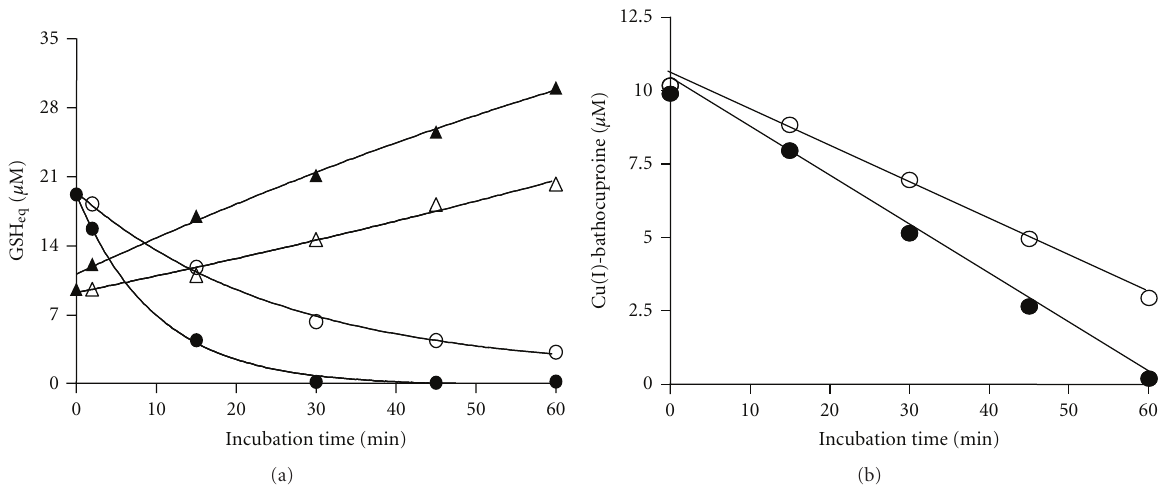
Figure 6: (a) Changes in the thiol-titratable groups and EDTA-releasable GSSG during the exposure of a Cu(I)-[GSH] 2 complex to Tempol. For the determination of TTG (circles), a mixture of DTNB (24 μ M) plus EDTA (2mM), and for that of GSSG (triangles), a mixture of NADPH (0.2mM) plus glutathione reductase (2U/mL) and EDTA (2mM) were added to samples obtained from the incubation (0–60 min at 30 ◦ C) of the Cu(I)-[GSH] 2 complex (10 μ M) both in the presence (closed symbols) or in the absence (open symbols) of Tempol (8 μ M). Results are expressed as GSH equivalents ( μ M). (b) Changes in copper (I) during the exposure of a Cu(I)-[GSH] 2 complex to Tempol. For the determination of Cu(I) (circles), bathocuproine (500 μ M) was added to samples obtained from the incubation (0–60 min, at 30 ◦ C) of the Cu(I)-[GSH] 2 complex (10 μ M) both in the presence (closed symbols) or in the absence (open symbols) of Tempol (8 μ M). Cu(I) was assayed at OD 480nm and the results expressed as Cu(I)-bathocuproine ( μ